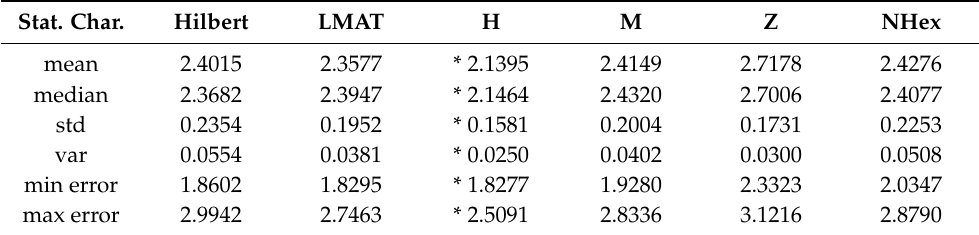
Table 5. Statistical characterization of all mobile path planning models in terms of std of errors for